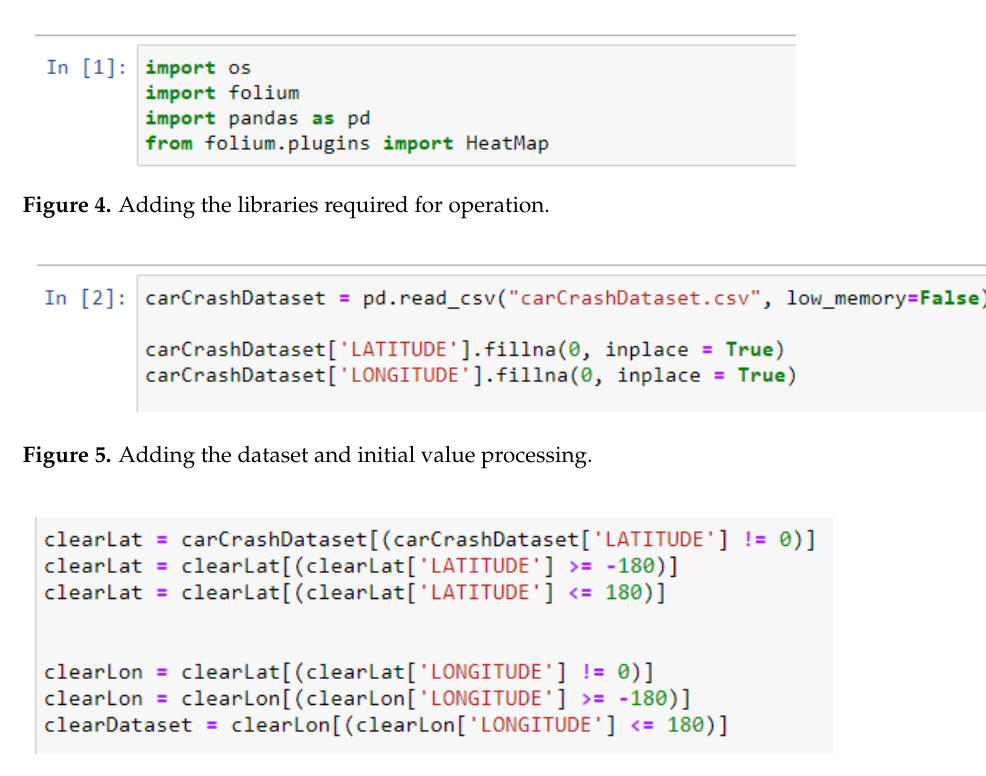
Figure 3. Running the Jupyter environment to work with the dataset.